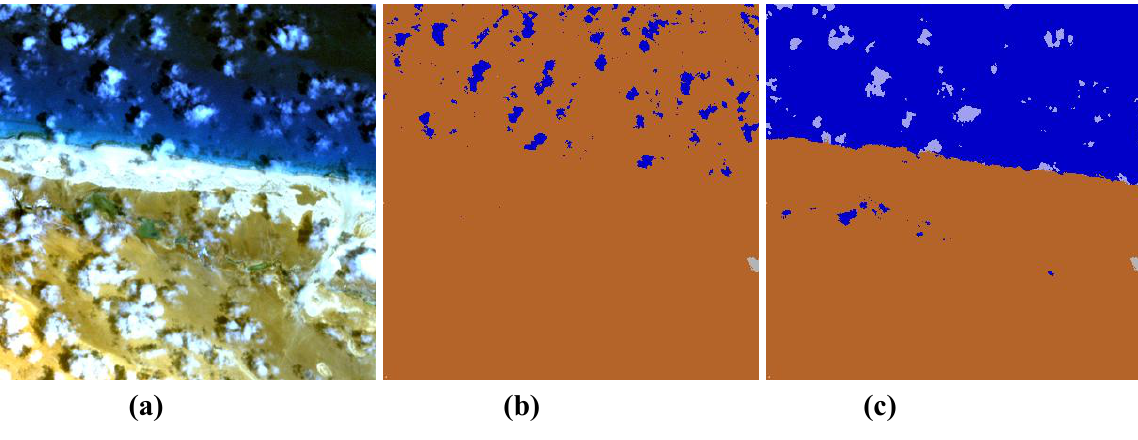
Figure 5 . Zoom of Figure 4, around label 1, and classified maps, see